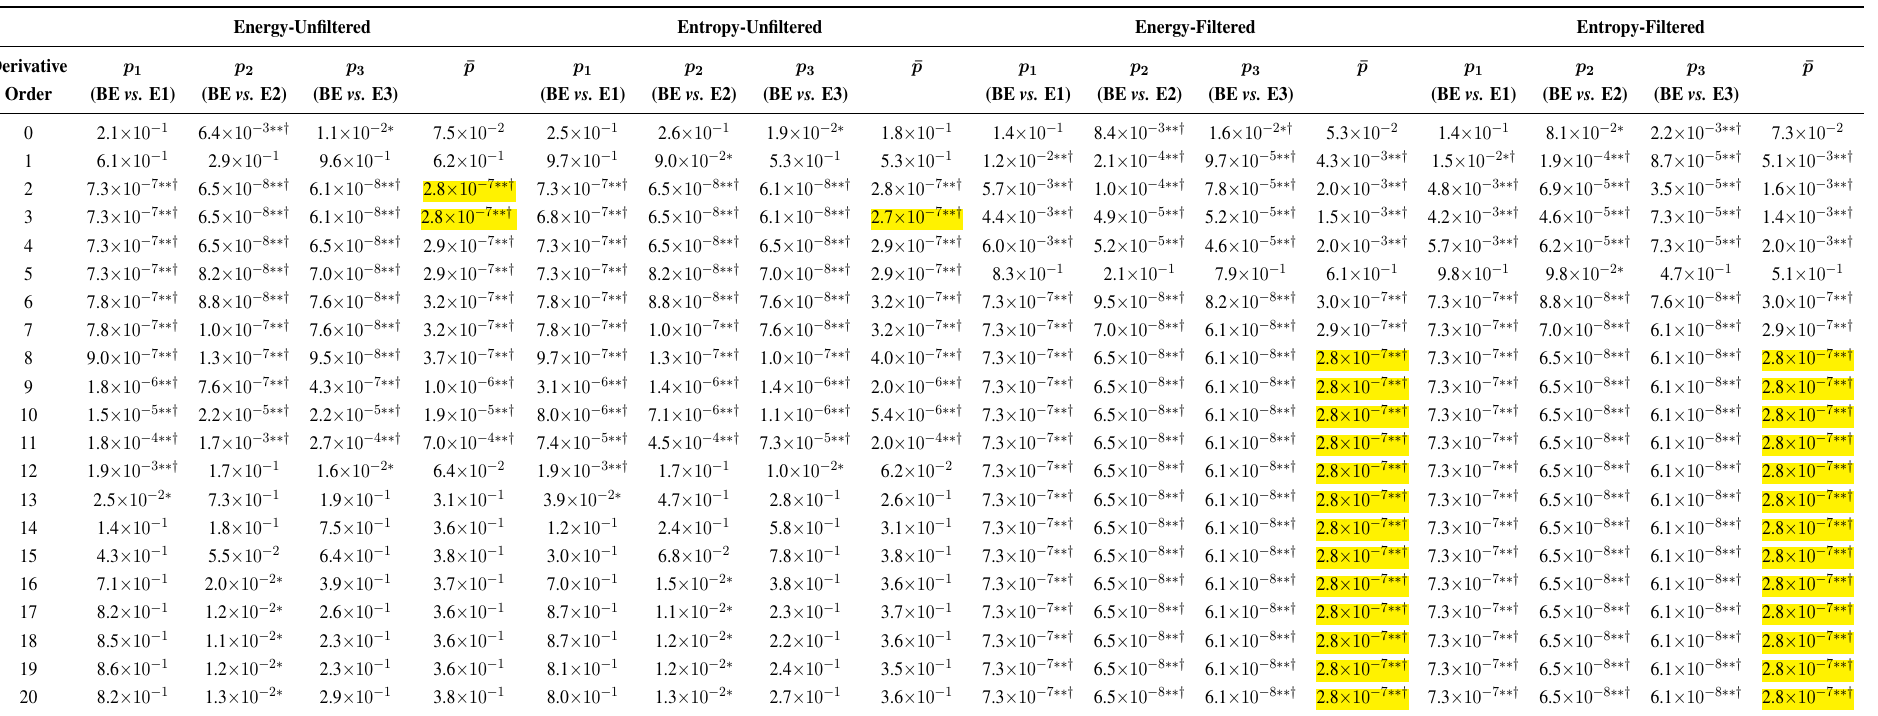
Table 2. Feature comparison in differentiating between before and after exercise measurements. The p -value of discriminating between before exercise (BE) and after three exercises (E1, E2 and E3) is calculated using the Mann-Whitney test. The average of the three p -values ( ¯ p ) is given in the last column of each feature. The lowest ¯ p of each feature is highlighted. Uncorrected p -values from the Mann-Whitney test, where * and ** indicate p ≤ 0 . 05 and p ≤ 0 . 005 , respectively; † indicates p -values that remain significant with a p ≤ 0 . 05 after post-correction (Bonferroni-Holm, α < 0 . 05